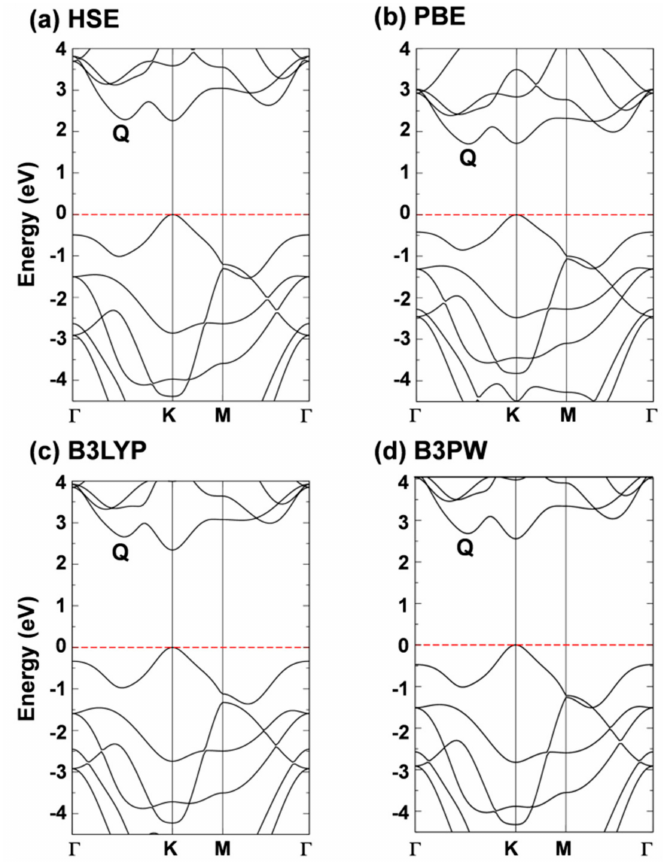
Figure 2. Band structures of monolayer tungsten diselenide (WSe 2 ) calculated by ( a ) HSE; ( b ) PBE;